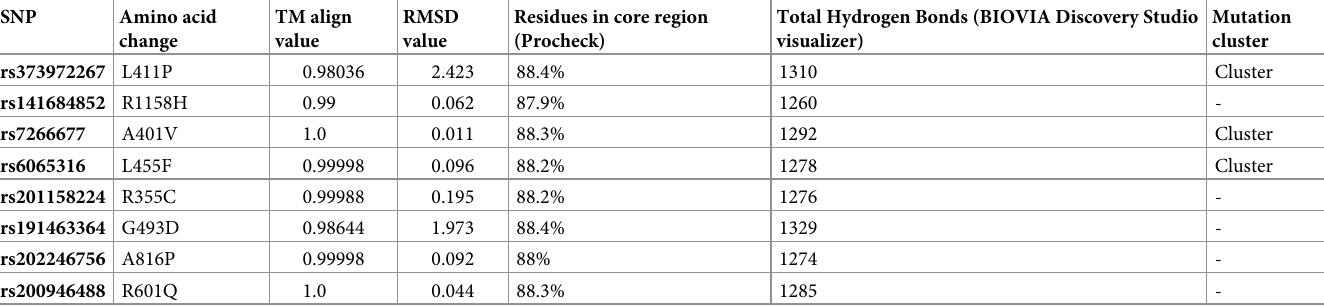
� Native protein structure has 1293 hydrogen bonds; “-” means no